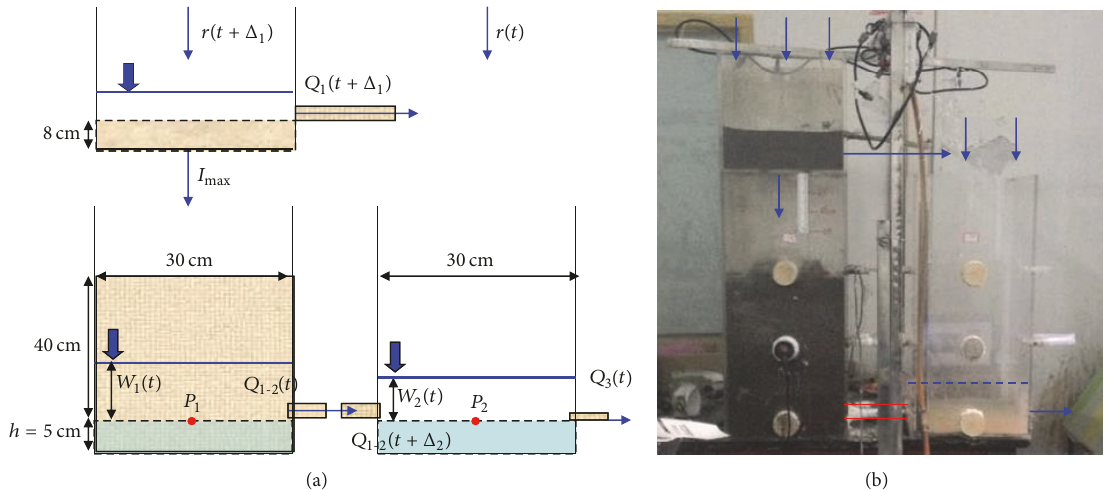
Figure 3: River-slope system modelling: (a) schematic diagram and (b) real scene.